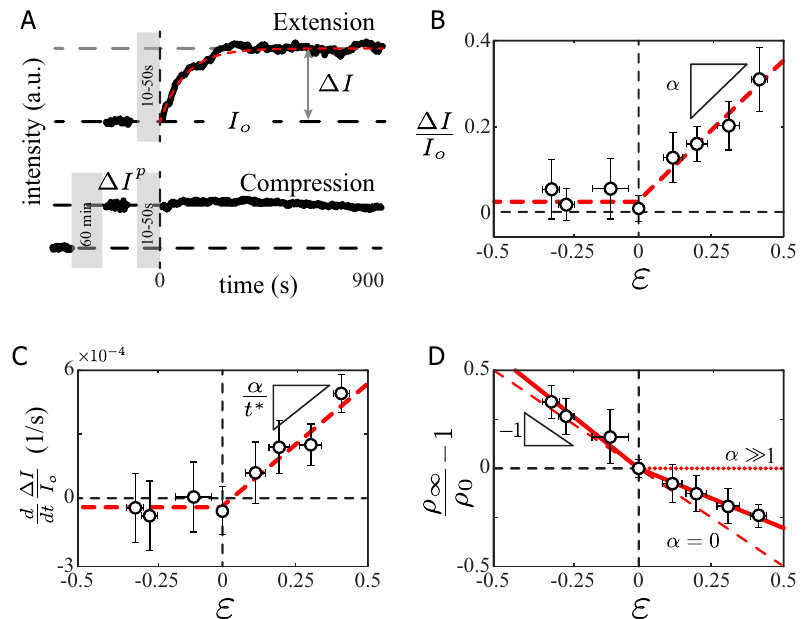
Figure 3. SF intensity response under stretch. ( A ) Total fluorescent intensity evolution (integrated along the bundle) at a constant stretch applied to the PDMS. ( B ) Variation of the F-actin intensity as a function of the applied strain. ( C ) Initial slope of the intensity evolution as a function of the applied strain. ( D ) Variation of the linear density, defined as the total intensity over the total SF length, a function of the applied strain. N = 12 SF for each data